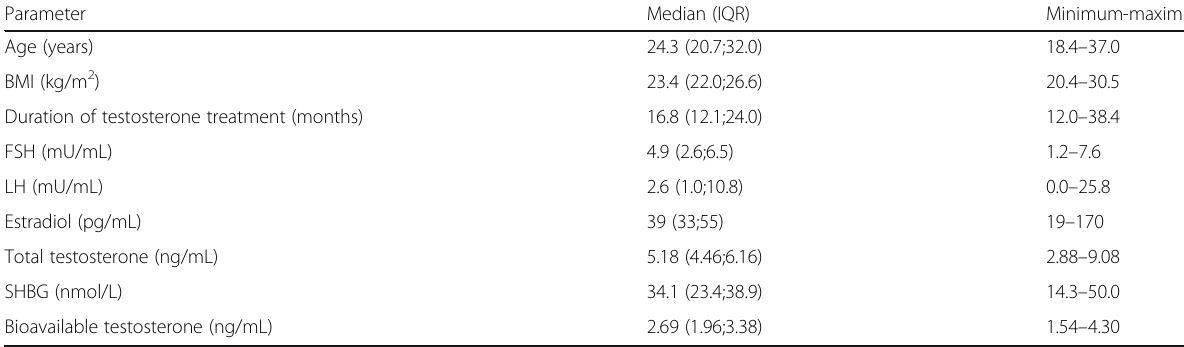
Table 1 Basic patient